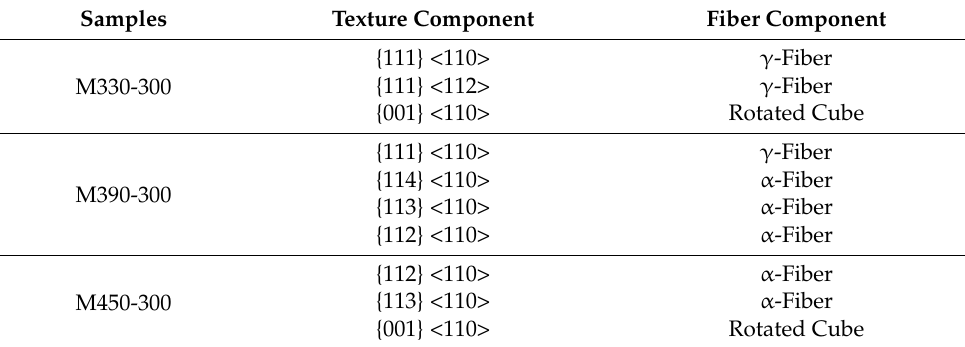
Figure 10. ODF´s for ϕ 2 = 45°: ( a ) M330-300, ( b ) M390-300 ( c ) M450-300. Figure 10. ODF’s for φ 2 = 45 ◦ : ( a ) M330-300, ( b ) M390-300 ( c ) M450-300. Table 4. Main textures components showed by studied samples (ferrite and bainite).